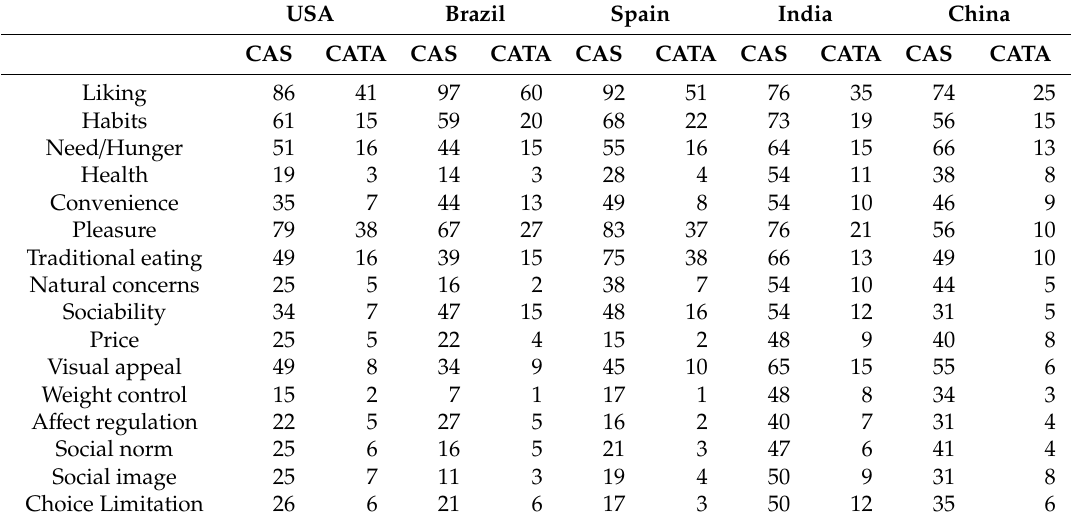
Table A4. Percentage of “agree” responses for CAS and CATA for all five countries for the respective desserts. *